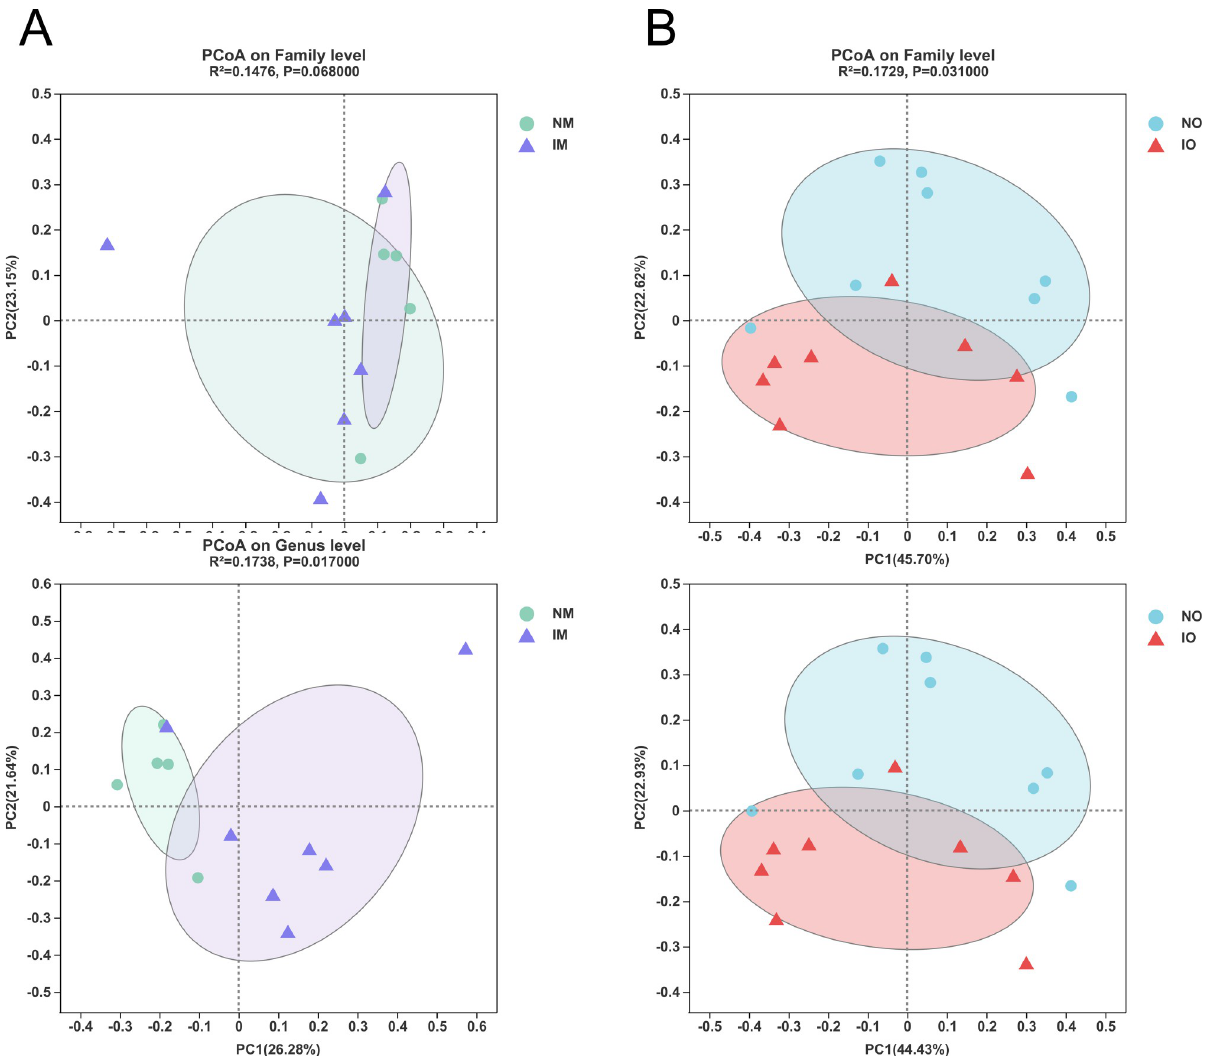
Fig 5. Fecal microbial composition analysis and beta-diversity analysis on maternal rats and offspring. (A, B) PCoA analysis was to explore the correlation of the composition of the microbiome on the family level and genus level of each group.